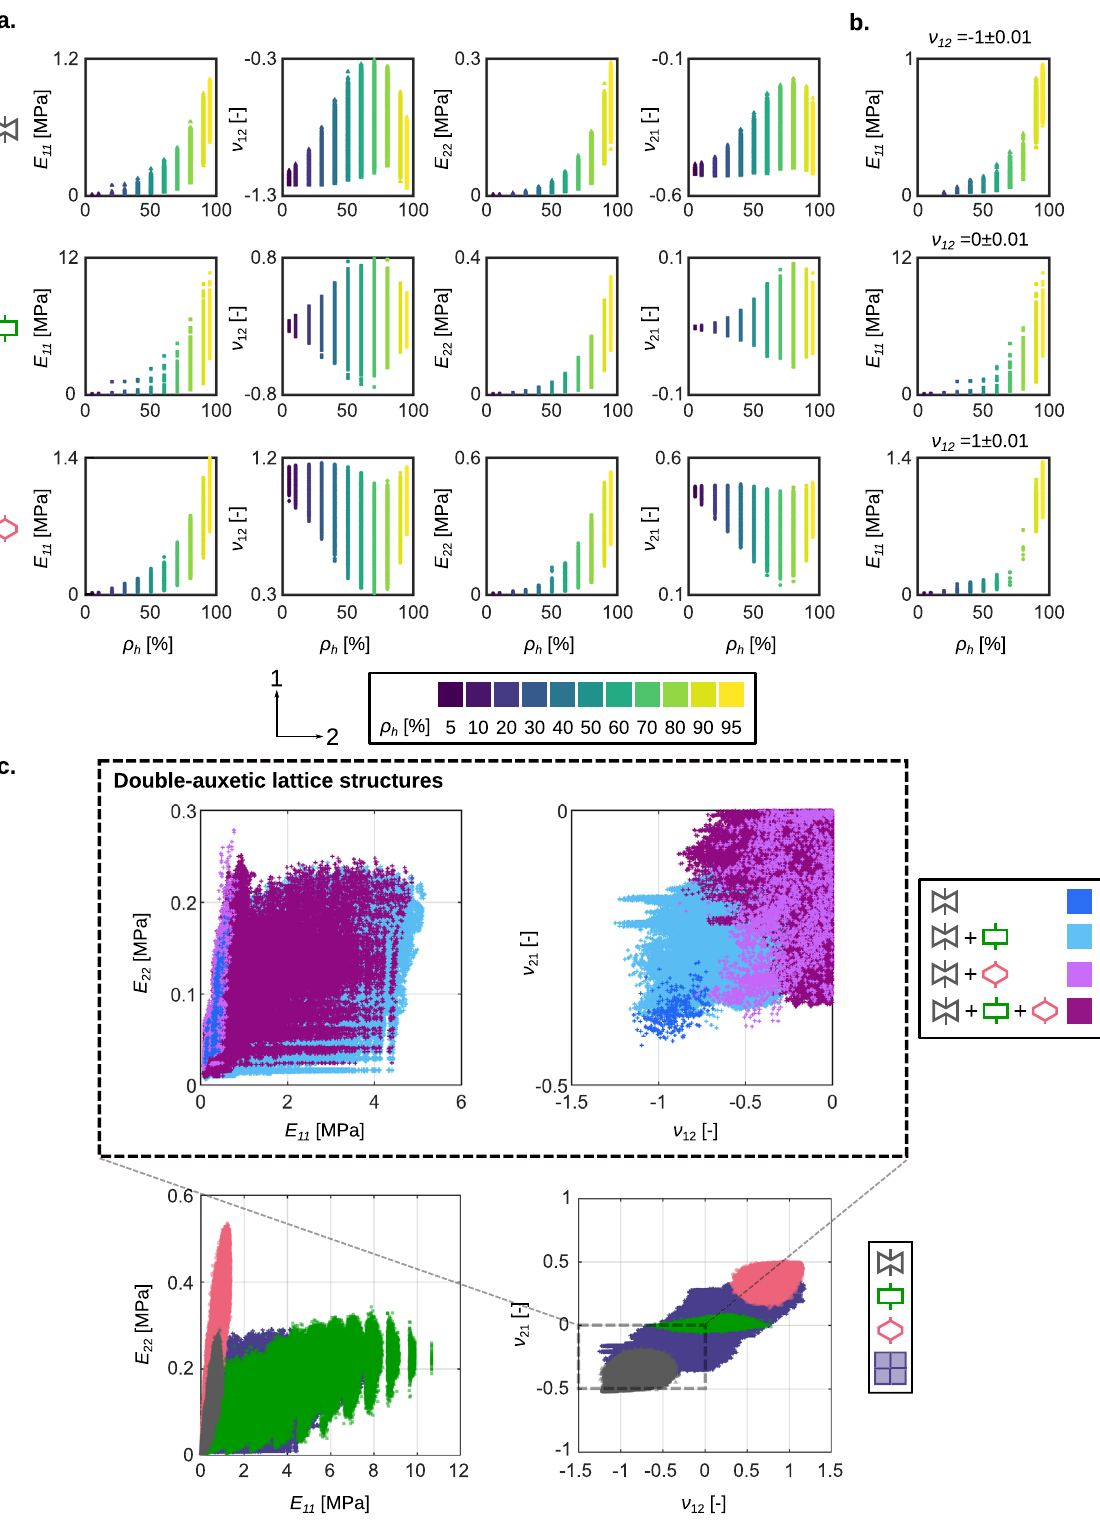
Fig. 2 The elastic properties of studied lattice structures with a focus on double-auxetic lattices. a The elastic properties ( E 11 ; ν 12 ; E 22 ; and ν 21 ) of the different types of unit cells for the different values of ρ . b The achievable range of the elastic moduli for some speci fi c values of the Poisson ’ s ratio (i.e., h ν ¼ (cid:3) 1 ± 0 : 01 ; ν ¼ 0 ± 0 : 01, and ν ¼ 1 ± 0 : 01) considering the different values of ρ . c The elastic properties corresponding to the single unit cell and 12 12 12 h four-tile designs with a focus on double-auxetic lattices. The magni fi ed view shows the distribution of double-auxetic structures by types of unit cells of constituent designs. Given the very large number of data points which makes the generation of the plots challenging, only the data points for which the FE models were directly solved (i.e., 1% of the data points) are plotted in Fig. 2.